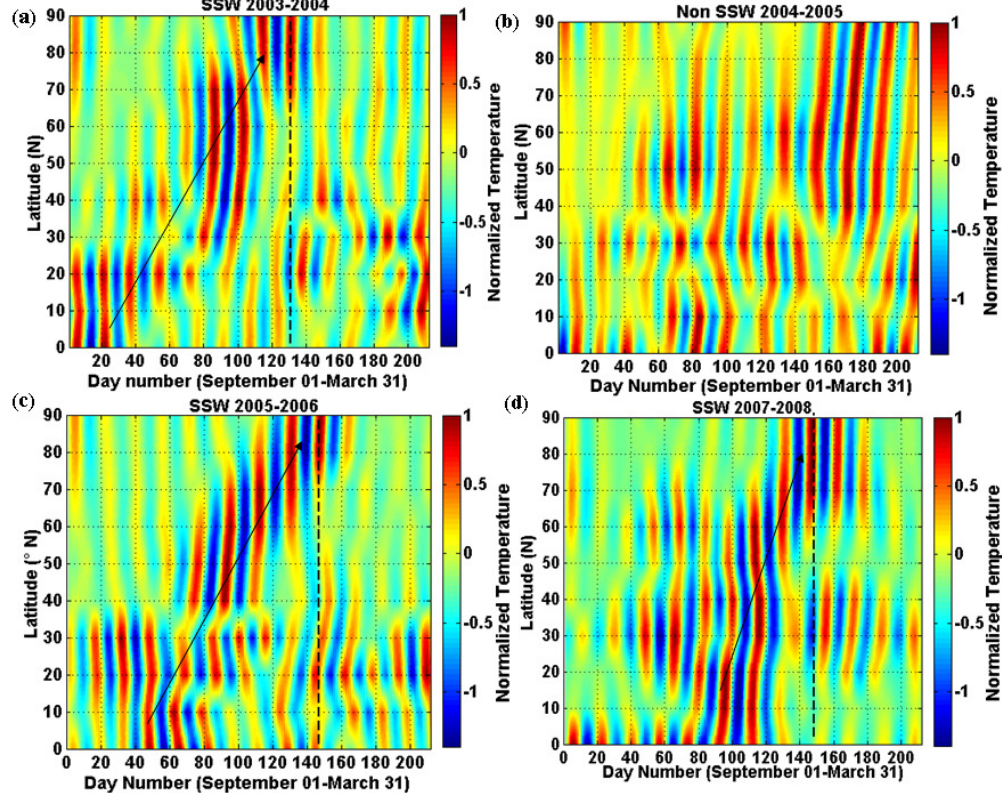
Fig. 2. The evolution of quasi 16-day wave from equator to North Pole during SSW years of (a) 2003–2004, (c) 2005–2006 (d) 2003–2004 and non SSW year (b) 2003–2004. The day of occurrence of the major SSW is marked in each figure as dotted